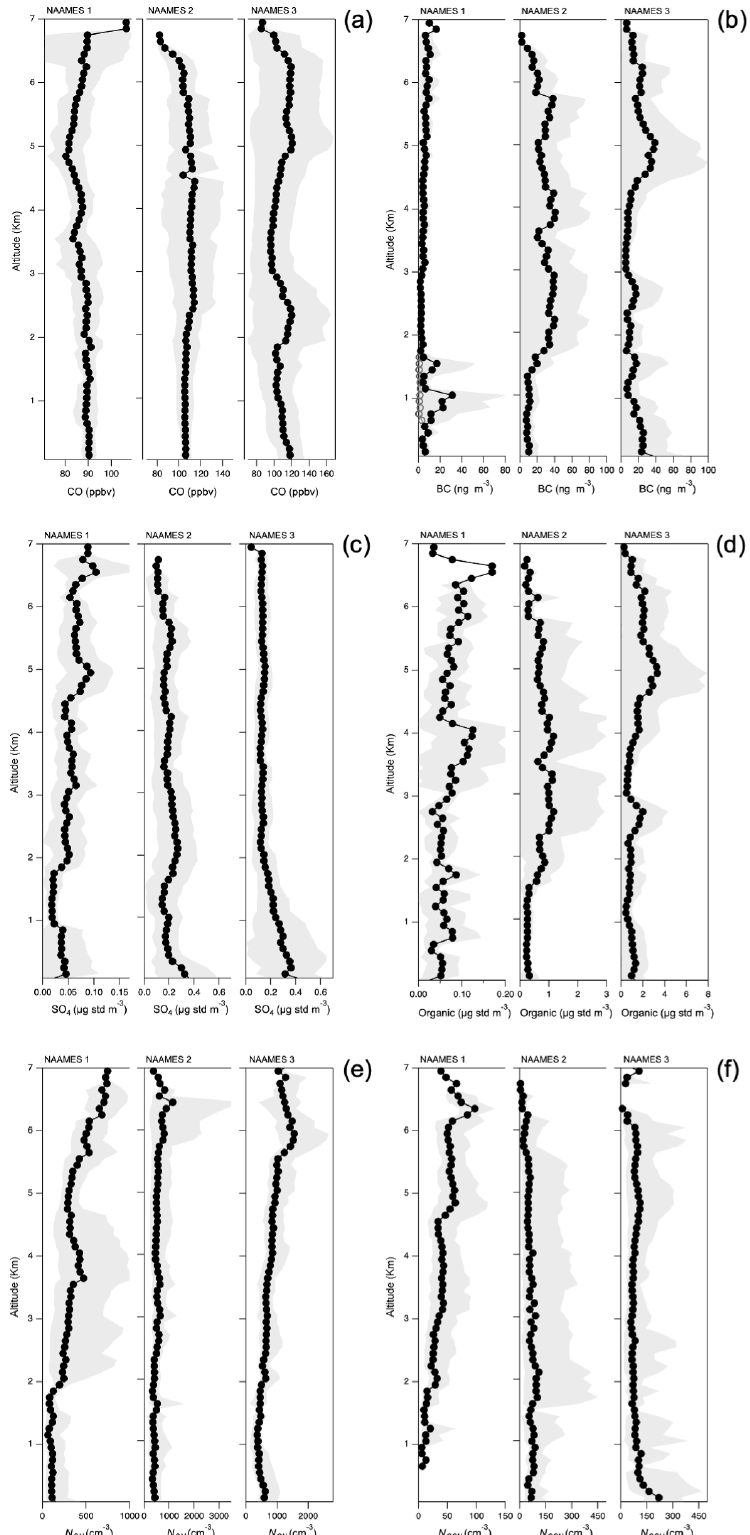
Figure 3. Vertical profiles of mean and standard deviation (grey shadow) of CO (a) , BC (b) , sulfate (c) , organics (d) , and geometric mean geometric standard deviation of N CN (e) , and N CCN (f) during the three NAAMES field campaigns. Empty grey dots in (b) , represent mean of BC when data affected by the ship-traffic events discussed in Sect. 3.2 are